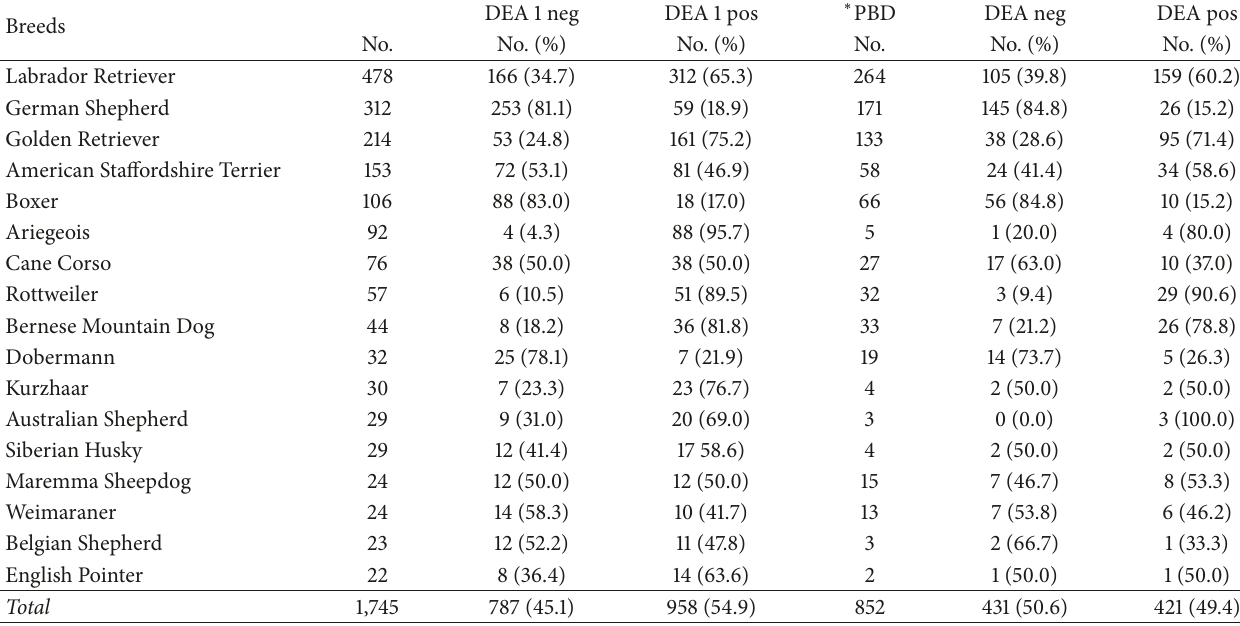
Table 4: Number of prospective blood